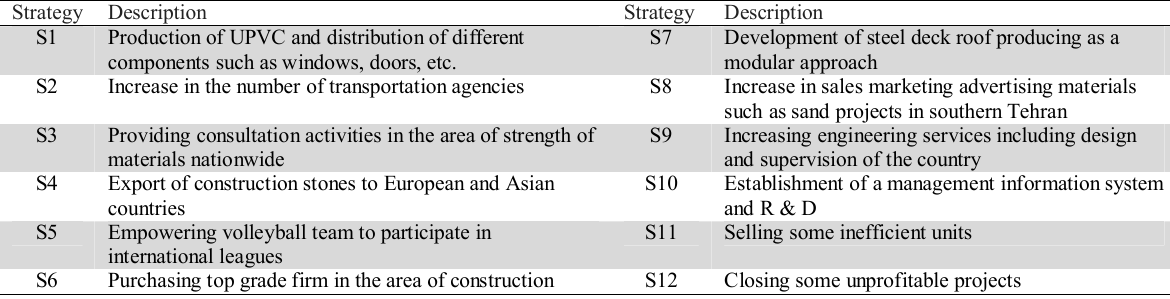
The summary of different strategies Strategy Description